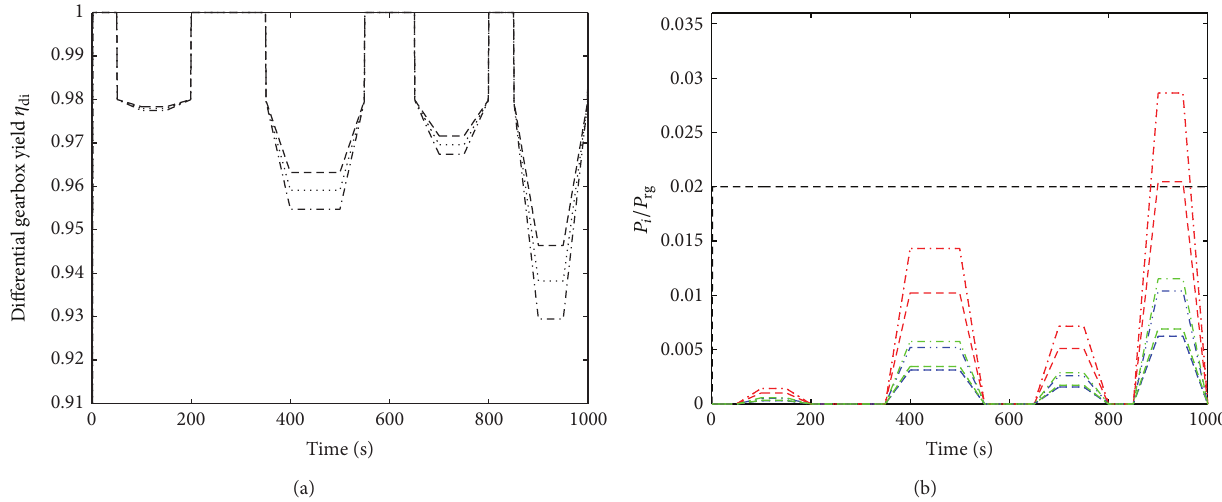
Figure 13: (a) Yield of a differential gearbox 𝜂 𝑑𝑖 with time 𝑡 ∈ [0,1000 s ] in the case of the complex path presented in Figure 12 with various ,𝜇 ) : (0.03,0.05) in a dashed line, (0.05,0.07) in a dash-dot line, and (0.03,0.07) in a dotted line. (b) Loss sets of friction coefficients (𝜇 ax / sa sh of the 𝑖 -mechanism (with 𝑖 = ( sa / pl , ax / sa , sa / sh , pl / sh ) ) with time 𝑡 ∈ [0, 1000 s ] in the case of the complex path presented ratio 𝑙 𝑖 = 𝑃 𝑖 /𝑃 rg = 0.96 which remained constant with time 𝑡 (black solid line), 𝑙 in Figure 12 with the same sets of friction coefficients as in (a): 𝑙 sa / pl (blue line), and 𝑙 (green line), 𝑙 sa / sh pl / sh